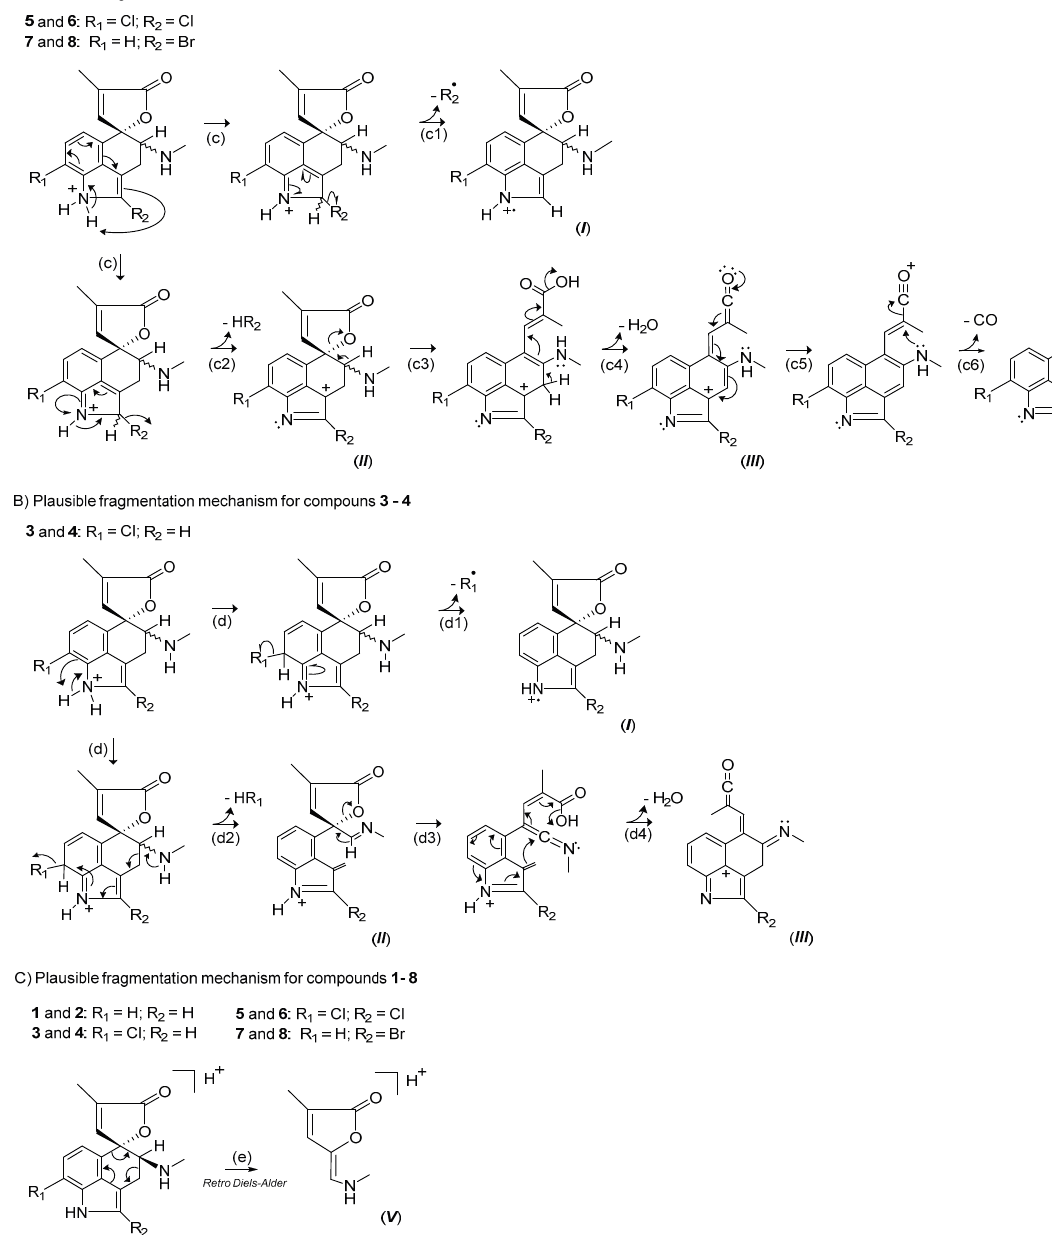
Figure 6. Plausible fragmentation mechanisms proposed to explain the product ions detected in the MS/HRMS spectra from ( A ) compounds 5 – 8 ; ( B ) compounds 3 and 4 ; and ( C ) compounds 1 – 8